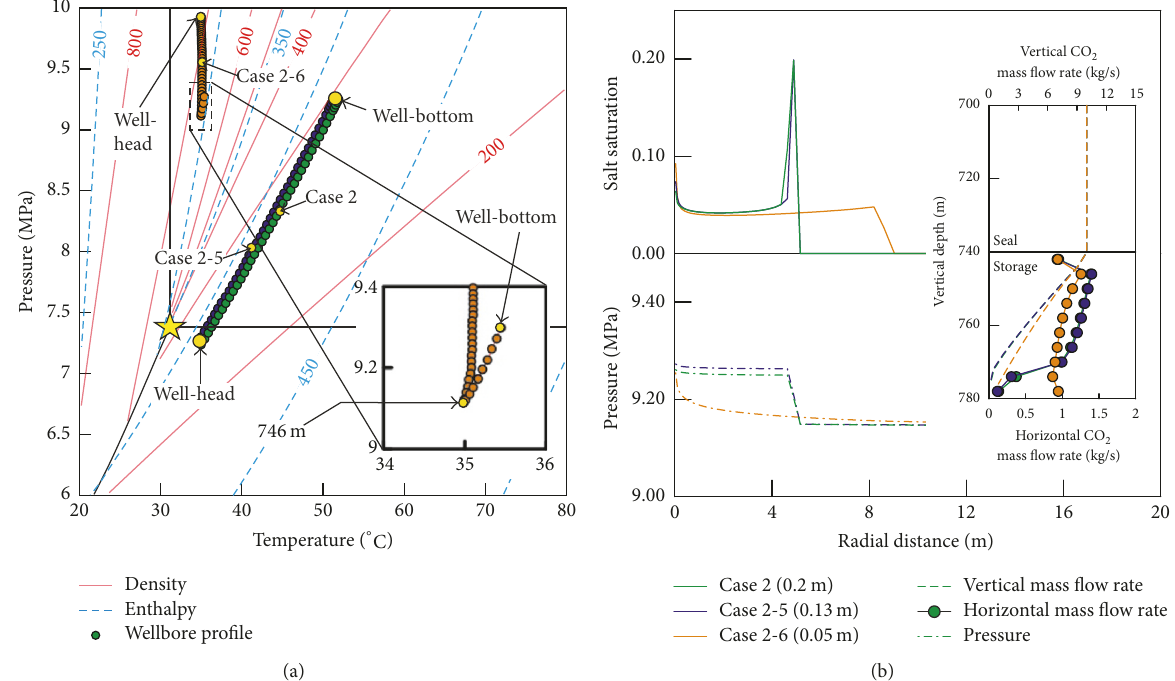
Figure 9: (a) Changes of CO 2 properties (density [kg/m 3 ] and enthalpy [kJ/kg]) within the wellbore and (b) development of salt saturation [-] and built-up pressure [MPa] at the bottom layer. The small figure represents both horizontal and vertical CO 2 mass flow rate [kg/s] within the wellbore with three different wellbore diameters (0.05, 0.13, and 0.2 m) after 1,095 days.